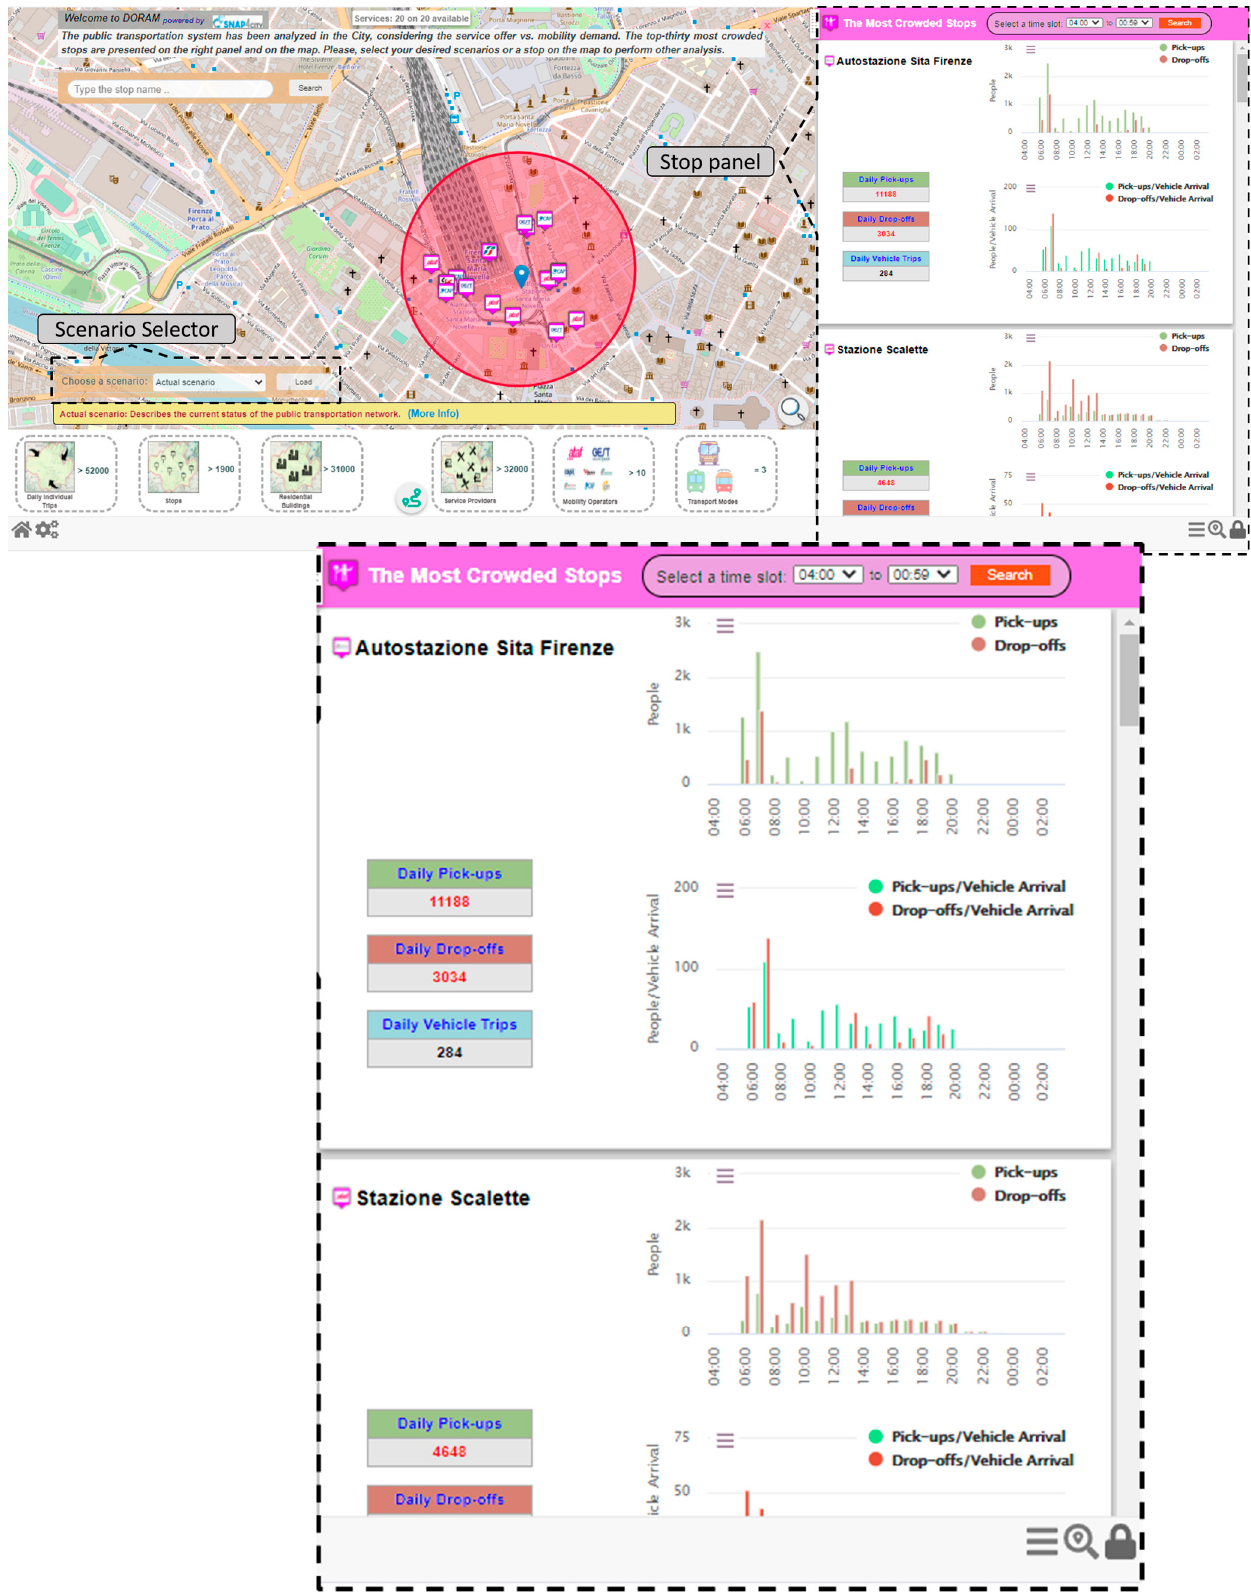
Figure 9. DORAM Figure 9. DORAM homepage.